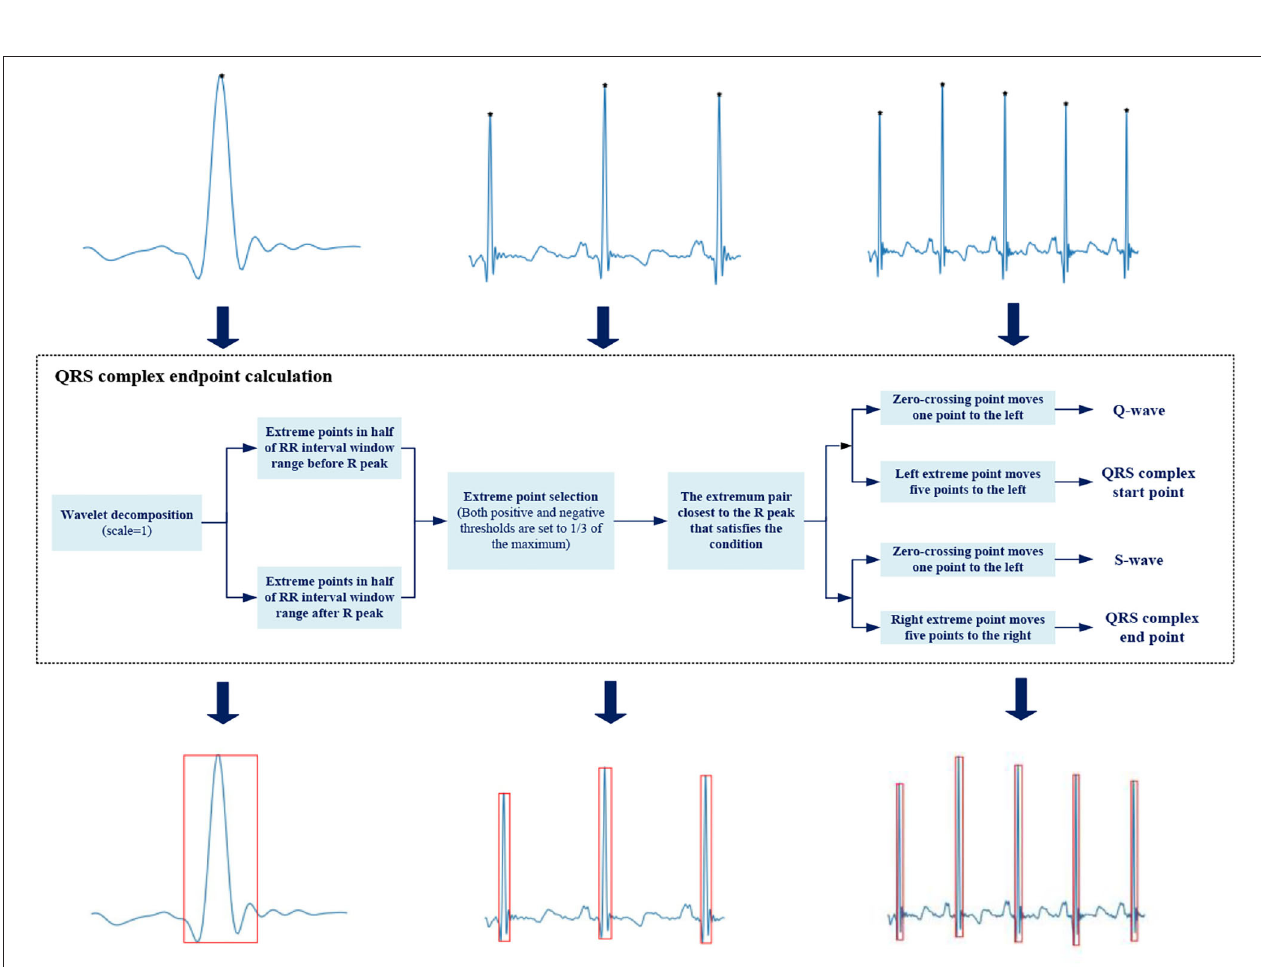
FIGURE 4 | Automatic heartbeats